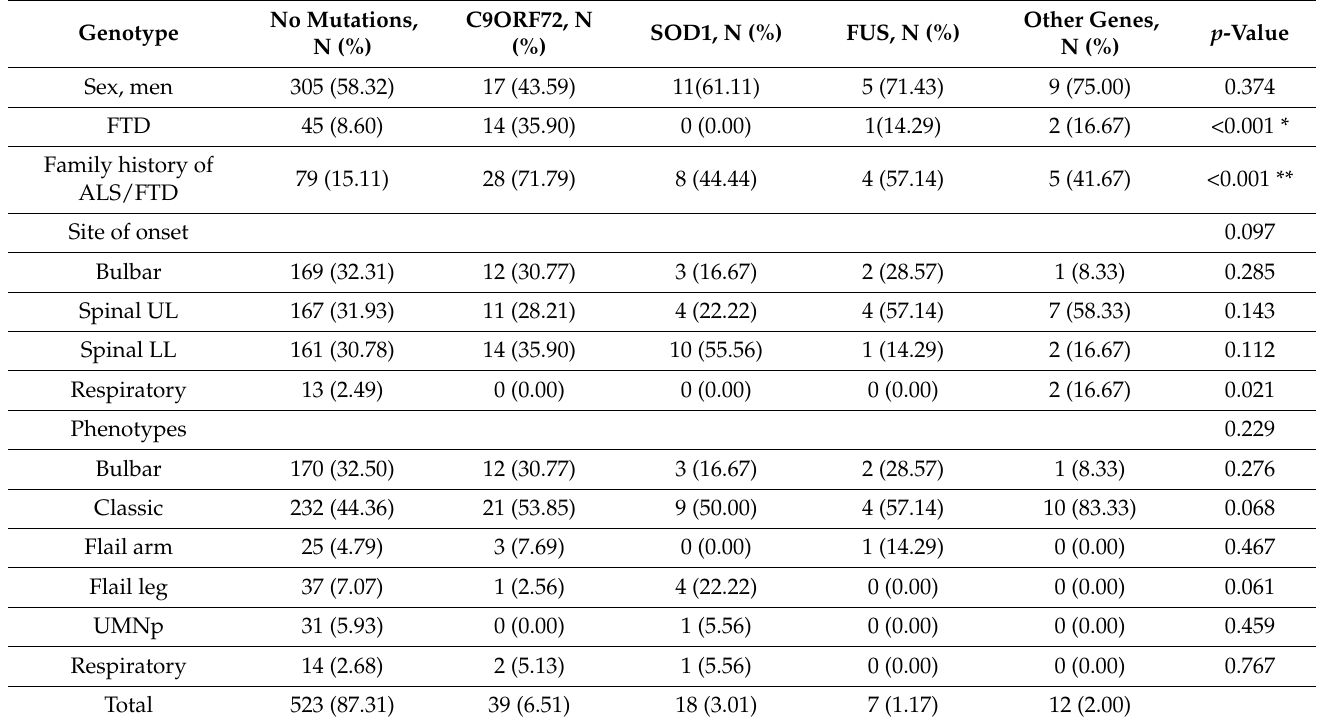
Table 3 shows differential distribution of main clinical features among genotypes tested with the chi-square test. Spinal UL: spinal upper limb; Spinal LL: spinal lower limb; UMN-p: Upper Motor Neuron predominant;